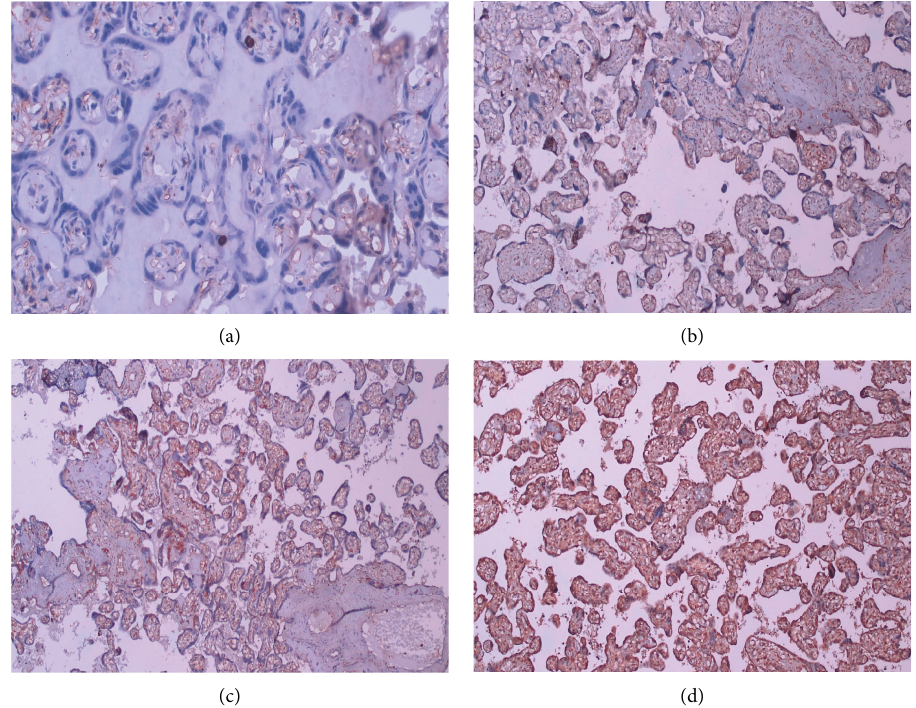
Figure 1: Immunohistochemical staining for TLR2 in placentas of mothers with hepatitis B. (a) TLR2 score of 0 (no villous trophoblast villi stained). (b) TLR2 score of 1 ( < 25% villous trophoblast villi stained). (c) TLR2 score of 2 (25–75% villous trophoblast villi stained). (d) TLR2 score of 3 ( > 75% villous trophoblast villi Table 2: Association of TLR2 expression in the placenta and the detection of HBV DNA. Placental TLR2